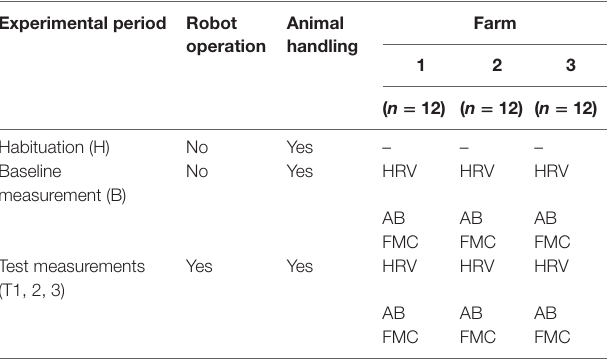
TaBle 1 | experimental protocol for data collection on three farms ( n = 36) from January to July 2013. experimental period robot animal operation